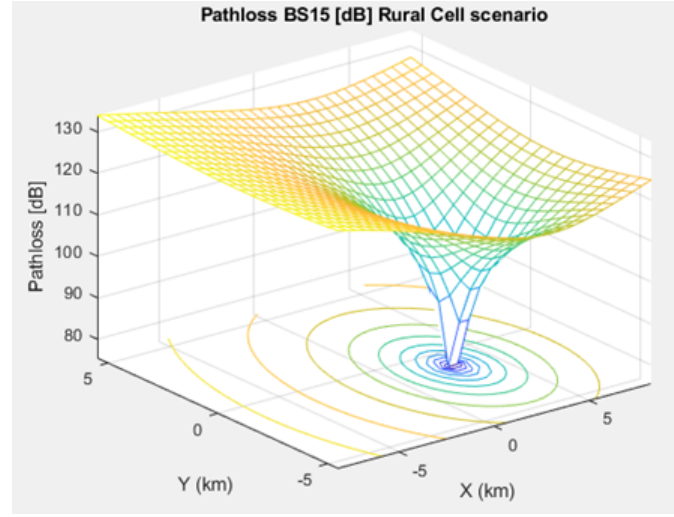
Figure 7. Path loss model for BS No. 15 in a rural macrocell scenario.